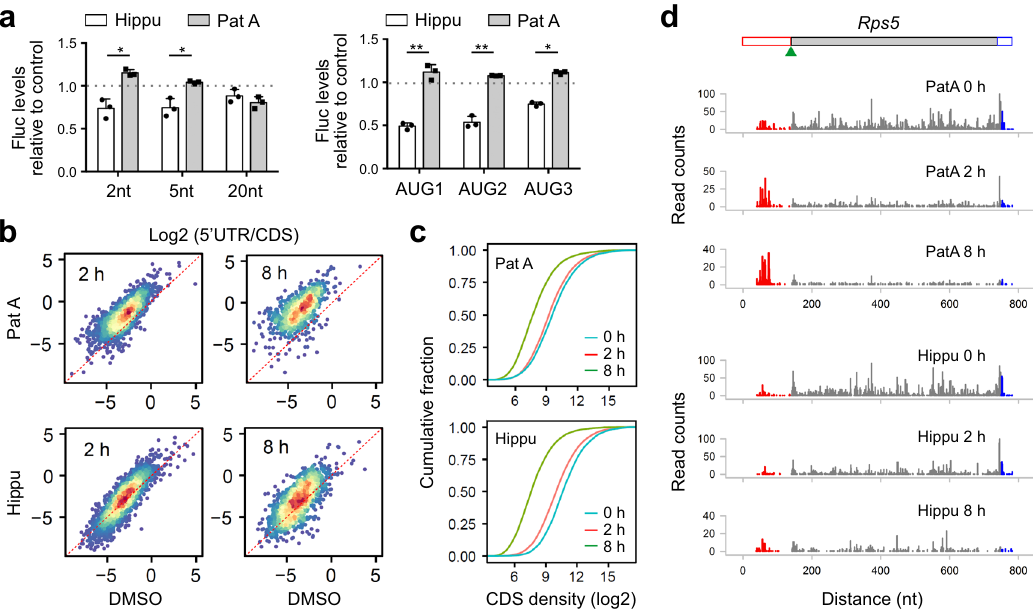
Fig. 5 eIF4A promotes PIC scanning in an ATPase-dependent manner. a Effects of Hippuristanol (Hippu) or Pateamine A (PatA) treatment on the translation ef fi ciency of Fluc mRNA reporters with ultra-short 5 ʹ UTR (top) or those containing three AUG codons near the 5 ʹ end (bottom). Transfected MEF cells were treated with 200 nM Hippu or 50 nM PatA and Fluc activities were quanti fi ed by real-time luminometry. Error bars: mean ± SEM; n = 3 biological replicates. Two-tailed t -test, * p < 0.05; ** p < 0.01. b Effects of Hippu or PatA treatment on 5 ʹ UTR ribosome occupancy revealed by Ribo-seq. Scatter plots show the correlation of read ratio (5 ʹ UTR/CDS) between vehicle control and treatment (50 nM PatA: top; 200 nM Hippu: bottom) for 2 h (left) or 8 h (right). c Effects of Hippu or PatA treatment on CDS ribosome occupancy revealed by Ribo-seq. From the same data sets as ( b ), CDS ribosome occupancies on individual transcripts were normalized to the number of mitochondrial reads and plotted as cumulative fractions. d A representative gene ( Rps5 ) shows differential 5 ʹ UTR read density (red) relative to the CDS (dark gray) after treatment with eIF4A modulators. Source data are provided as a Source Data fi